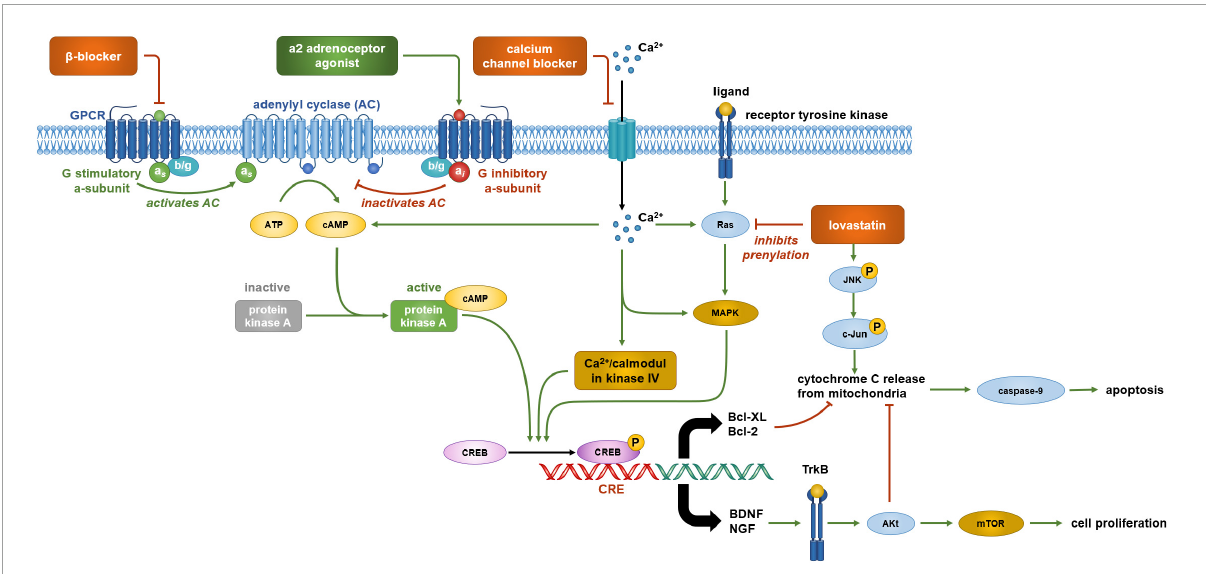
FIGURE5 Cell signaling pathways that are potentially involved in regulating neural stem cell (NSC) viability and proliferation. α 2 adrenergic receptors are coupled with an inhibitory G protein ( G i ) and β -adrenergic receptors are coupled with stimulatory G protein ( G s ). Activation of α 2 adrenergic receptors by agonists guanabenz, clonidine, or prazosin reduces cyclic AMP (cAMP) formation and cAMP response element-binding protein (CREB) phosphorylation. Propranolol has a similar effect by blocking the stimulatory action of the G s α subunit. CREB phosphorylation activates the transcription of brain derived neurotrophic factor (BDNF) and nerve growth factor (NGF) which promote cell proliferation by binding to tyrosine receptor kinase B (TrkB) activating the mTOR complex via Akt. Hence, lowering CREB phosphorylation by α 2 adrenergic receptors agonists and β -adrenergic receptors antagonists may reduce NSC proliferation. cAMP response element-binding protein phosphorylation is also important in the transcription of key genes involved in cell survival such as the anti-apoptotic proteins Bcl-2 and Bcl-XL, and hence, may be targets of lovastatin treatment. Lovastatin inhibits the prenylation of Ras which plays a role in CREB phosphorylation by activating MAPK. This reduction in CREB phosphorylation decreases Bcl-2 and Bcl-XL expression, upregulating apoptosis. Lovastatin also activates c-Jun N terminal kinases (JNK) which further upregulate apoptosis via the activation of pro-apoptotic proteins that stimulate the release of cytochrome c from mitochondria. Cytochrome c activates caspase-9 which initiates apoptosis. Akt, activated by growth factor binding to TrkB, increases cell viability by inhibiting pro-apoptotic proteins, preventing the activation of caspase-9 and apoptosis. Therefore, a reduction in BDNF and NGF gene expression by lovastatin reducing the inhibition of apoptosis may be the underlying mechanism explaining the decreased NSC viability after treatment. An influx of calcium into a cell is important in this signaling cascade as it further stimulates cAMP formation and CREB phosphorylation by calmodulin kinase IV. Blocking this influx of calcium using an L-type calcium channel blocker, such as nifedipine, would reduce these actions. As a result, L-type calcium channel blockers may reduce cell viability by the reduction of CREB phosphorylation, decreasing levels of anti-apoptotic protein Bcl-2 as well as the growth factors BDNF and